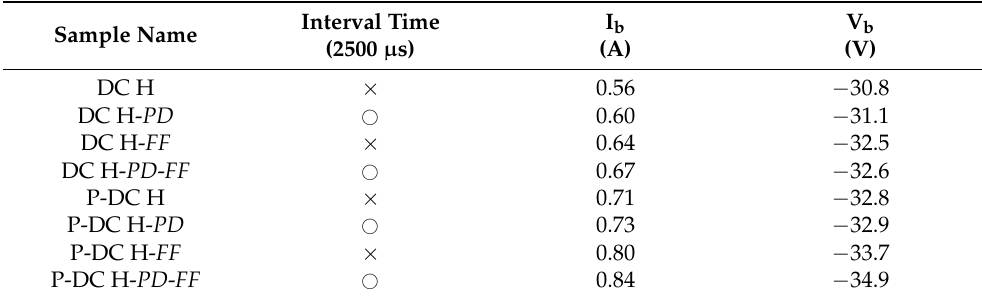
Figure 2. Waveforms of ( a ) target voltage (V t ), ( b ) target current (I t ), ( c ) bias voltage (V b ), and ( d ) bias current (I b ) without specifying the operating mode. Table 3. I b and V b of TiN coatings obtained under various HiPIMS operating modes and bias power settings. ( × : without specifying target, A or